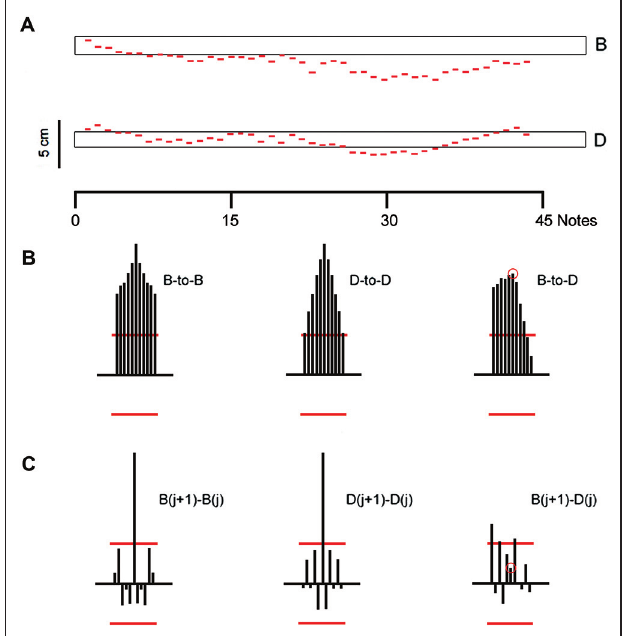
FIGURE 2 | (A) Subject shifts between the same two notes as in Figure 1 without the use of bow (and eyes are closed). For reference, the same “pitch window” is again shown. (B) Serial correlation coefficients for the note sequences shown above. Left: serial auto-correlation coefficients for Note B, lags − 5 to + 5. Middle: same for note D. Right: cross-serial coefficients with note B the reference note. (C) Serial correlation coefficients for the sequential differences between notes. Left: Serial auto-correlation coefficients for the sequential differences between notes B. Middle: same for note D. Right: cross-serial correlations between sequential note B and note D